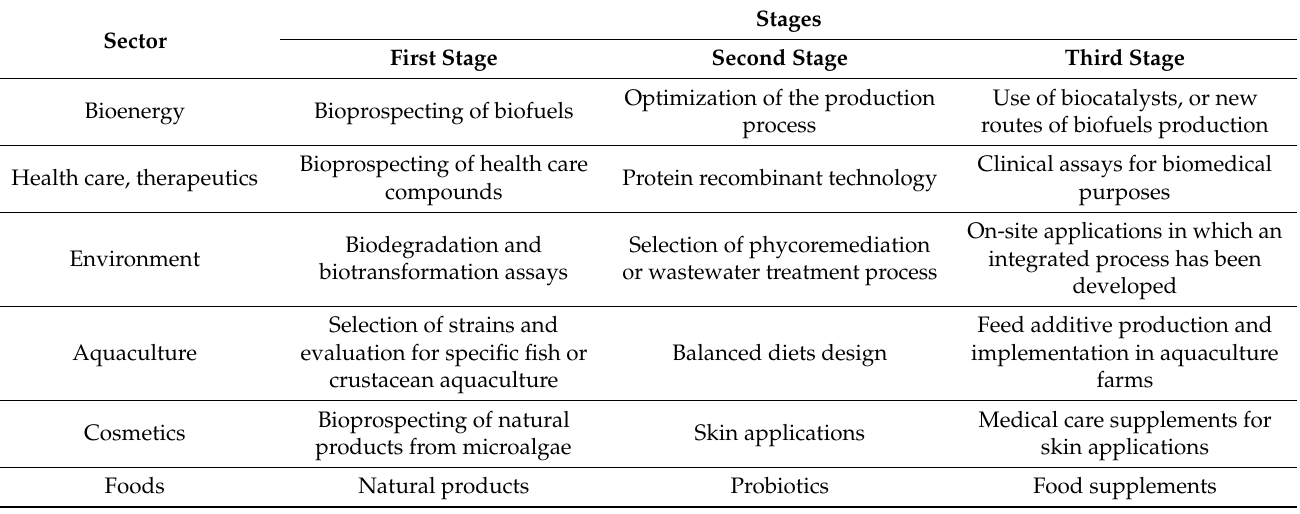
Table 1. Microalgal biotechnology developments visualized in terms of stages according to the application sector.